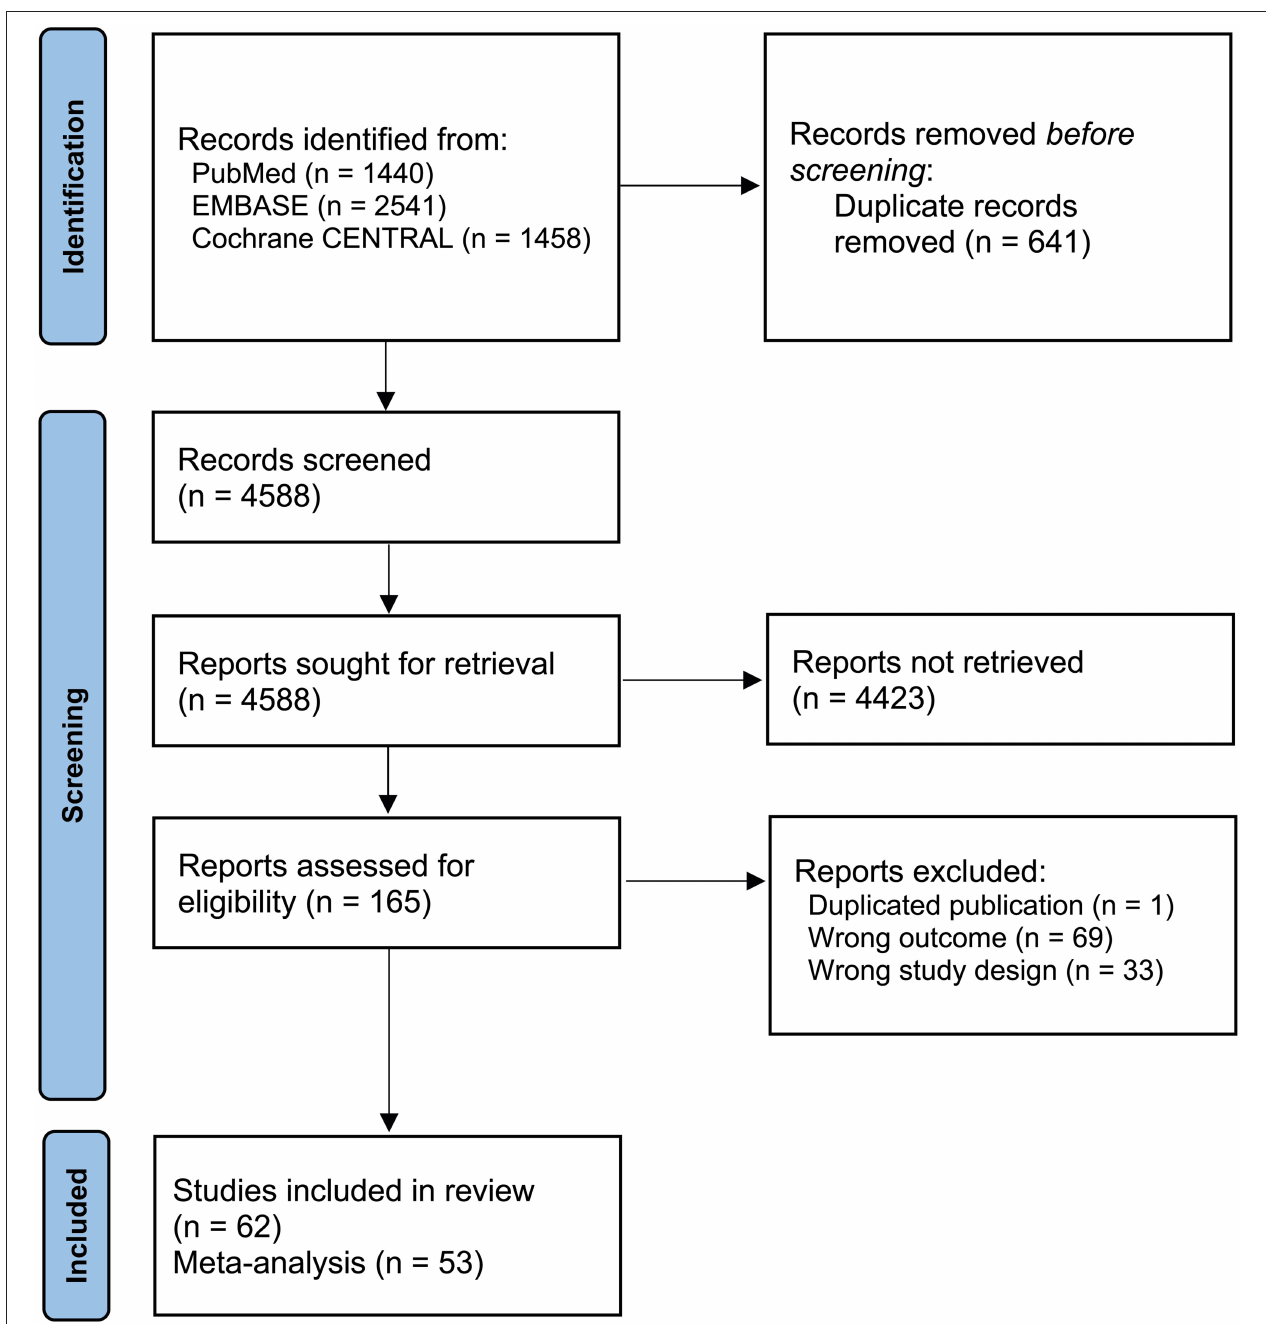
FIGURE 1 | Study flow